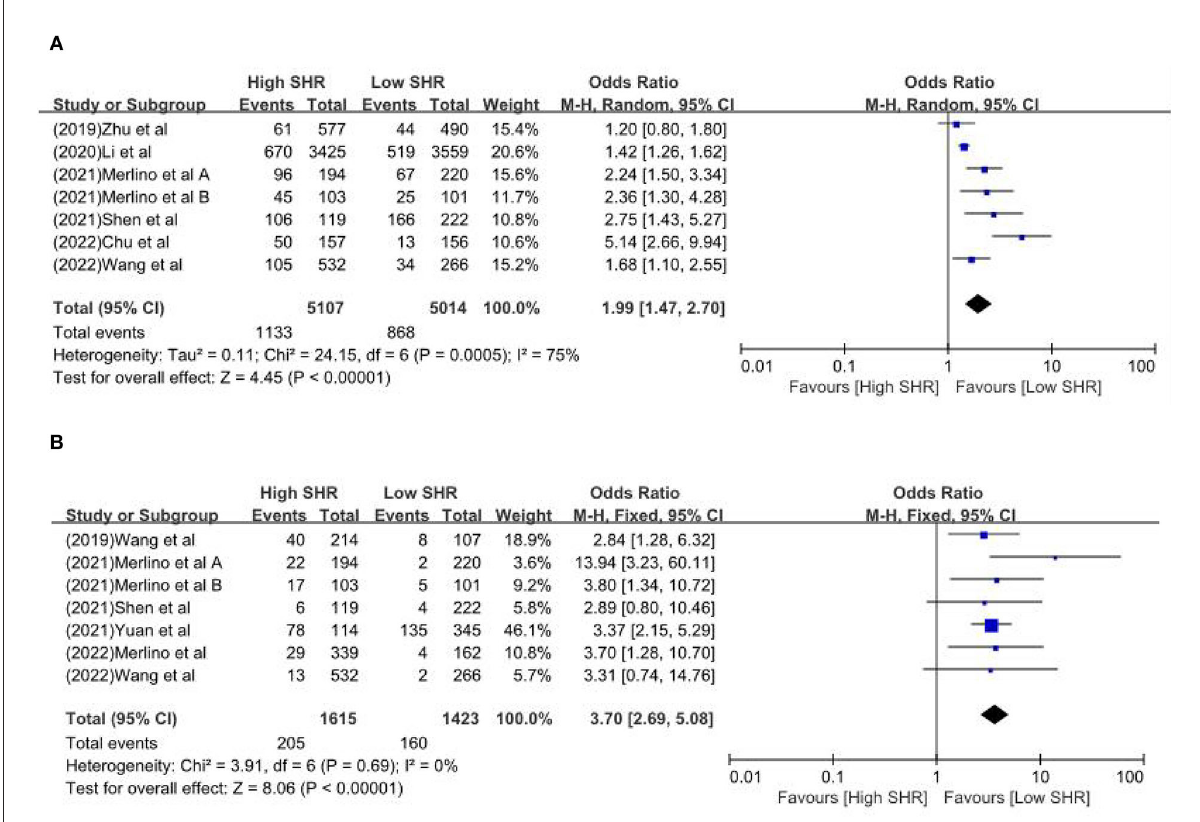
FIGURE3 The (A) Neurological deficit and (B) hemorrhagic transformation between high SHR and low SHR groups.